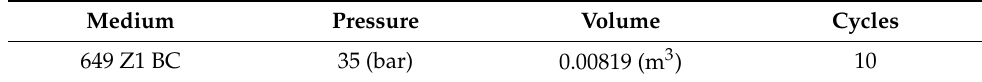
Figure 10. Abrasive flow machining (AFM) tooling dedicated to small AM closed impellers. Table 5. AFM process parameters.